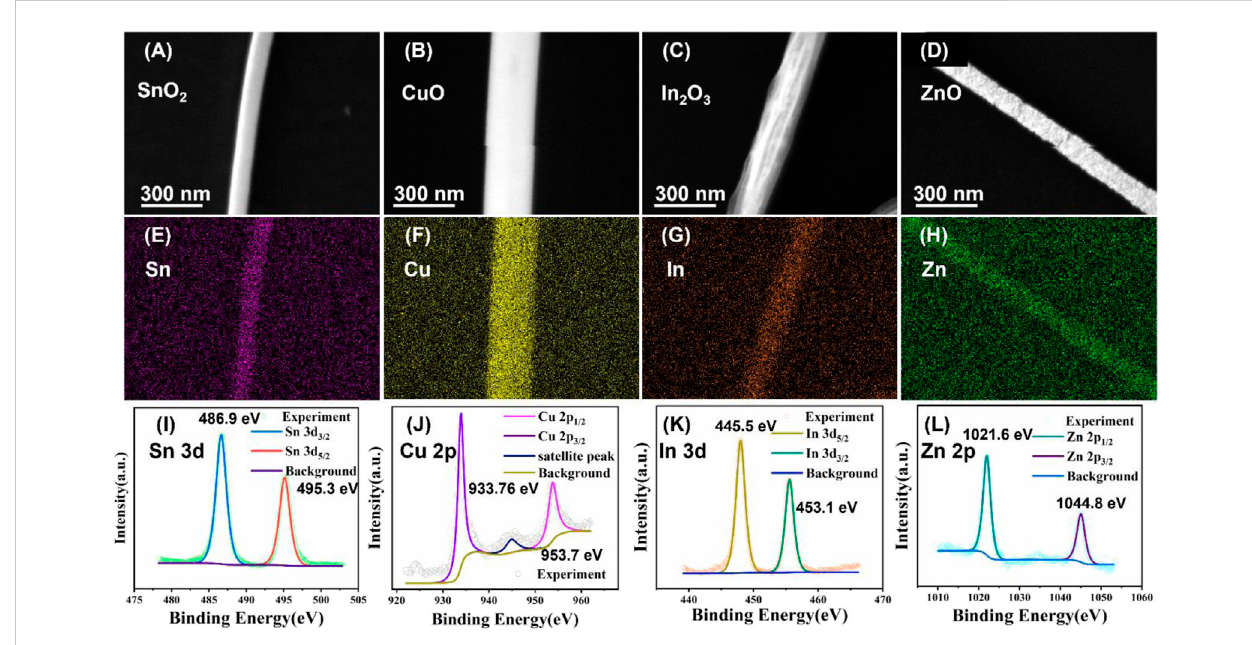
FIGURE 3 Magni fi edSEMimageofthefournano fi bers (A) SnO 2 , (B) CuO, (C) In 2 O 3 ,and (D) ZnOgassensor.EDSmappingoffournano fi bers (E) SnO 2 , (F) CuO, (G) In 2 O 3 , and (H) ZnO gas sensor. XPS spectra of four nano fi bers (I) SnO 2 , (J) CuO, (K) In 2 O 3 , and (L) ZnO gas sensor.